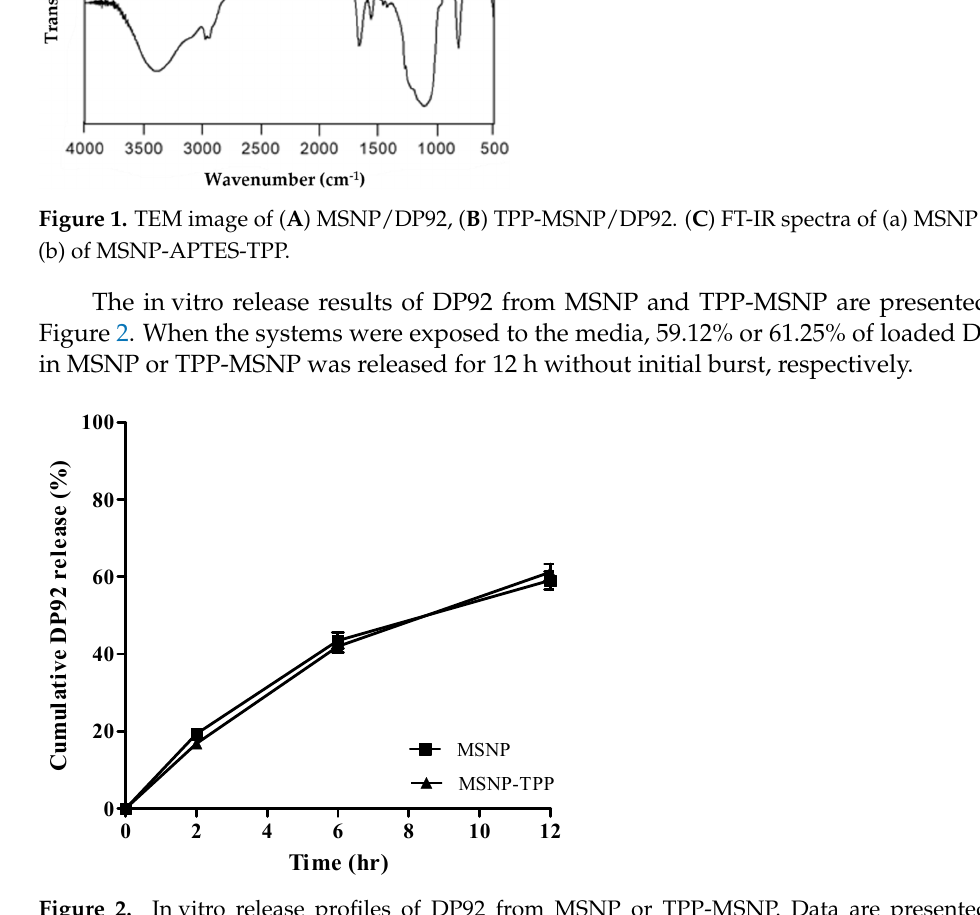
Figure 2. In vitro release profiles of DP92 from MSNP or TPP-MSNP. Data are presented as mean ± SD ( n = 3).